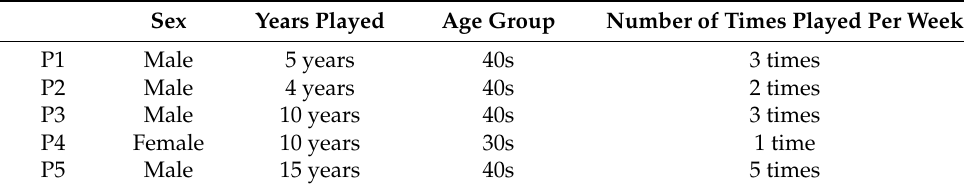
Table 1. Description of Participants of Interviewed.